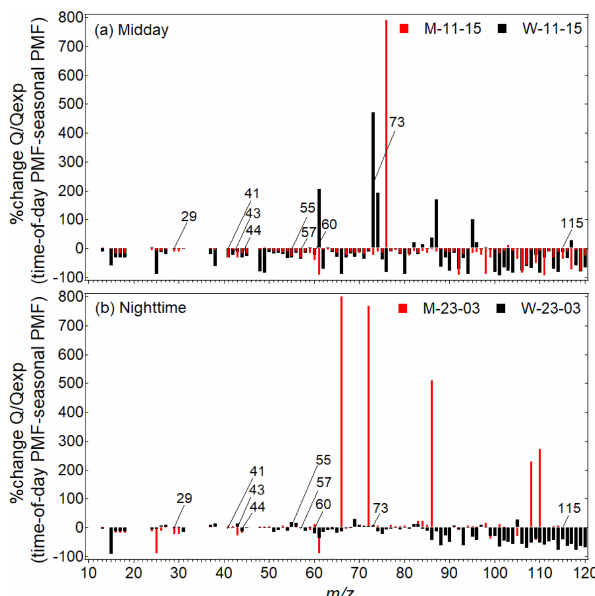
Figure 10. Percent change of Q/Q exp at different m/z s between the seasonal PMF approach and the time-of-day PMF approach in (a) midday and (b) nighttime periods. Key m/z s show a lower Q/Q exp in the time-of-day PMF approach compared to the seasonal PMF